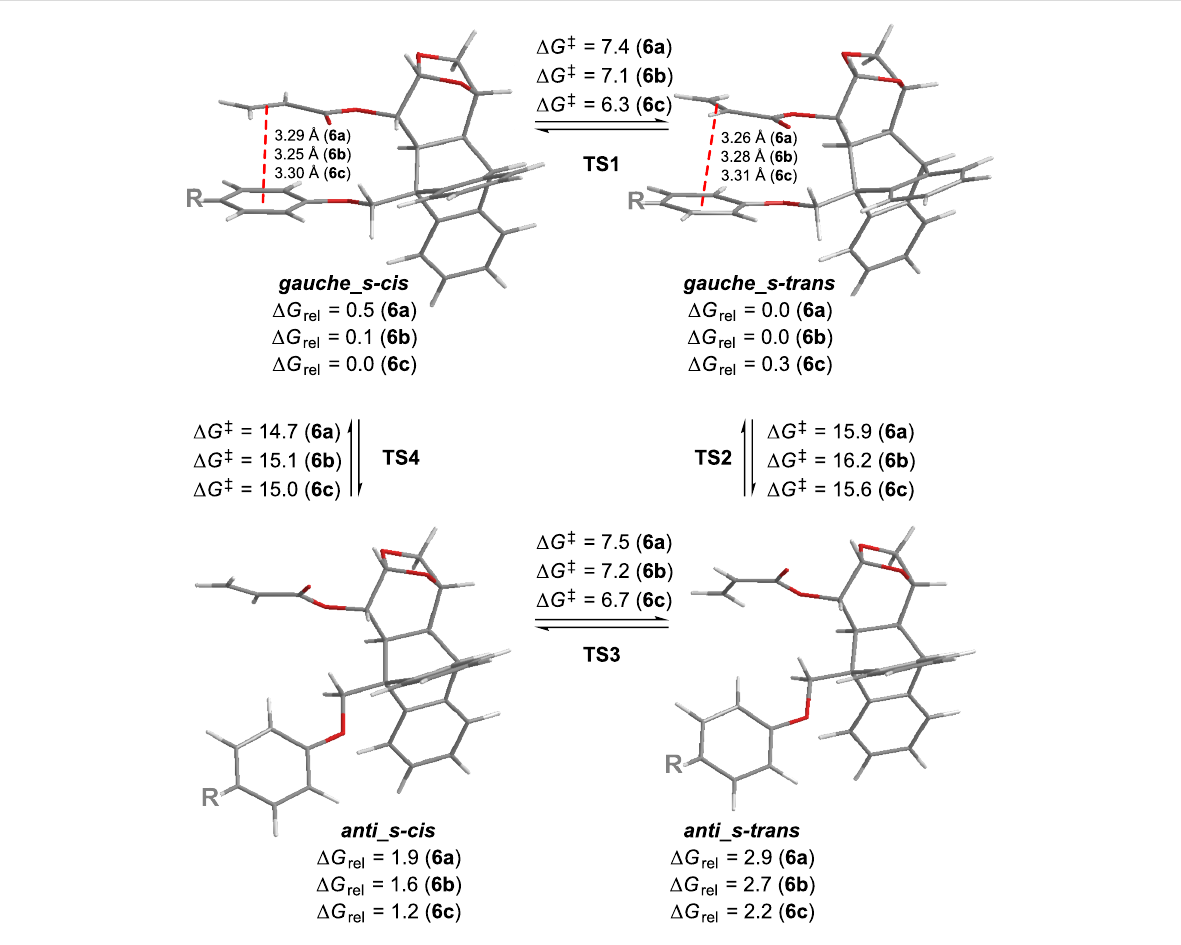
Figure 4: M06-2X/6-31+G(d) Gibbs free energy profiles (in kcal/mol) computed for the conformational equilibriums of 6a – c .